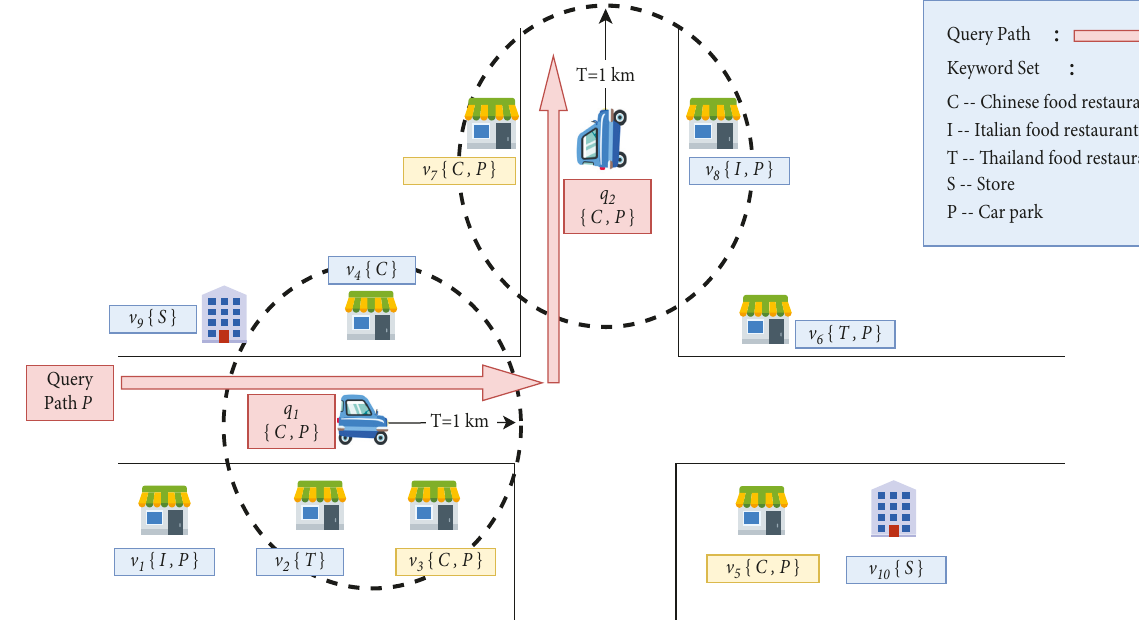
Figure 1: Example of the path based continuous spatial keyword